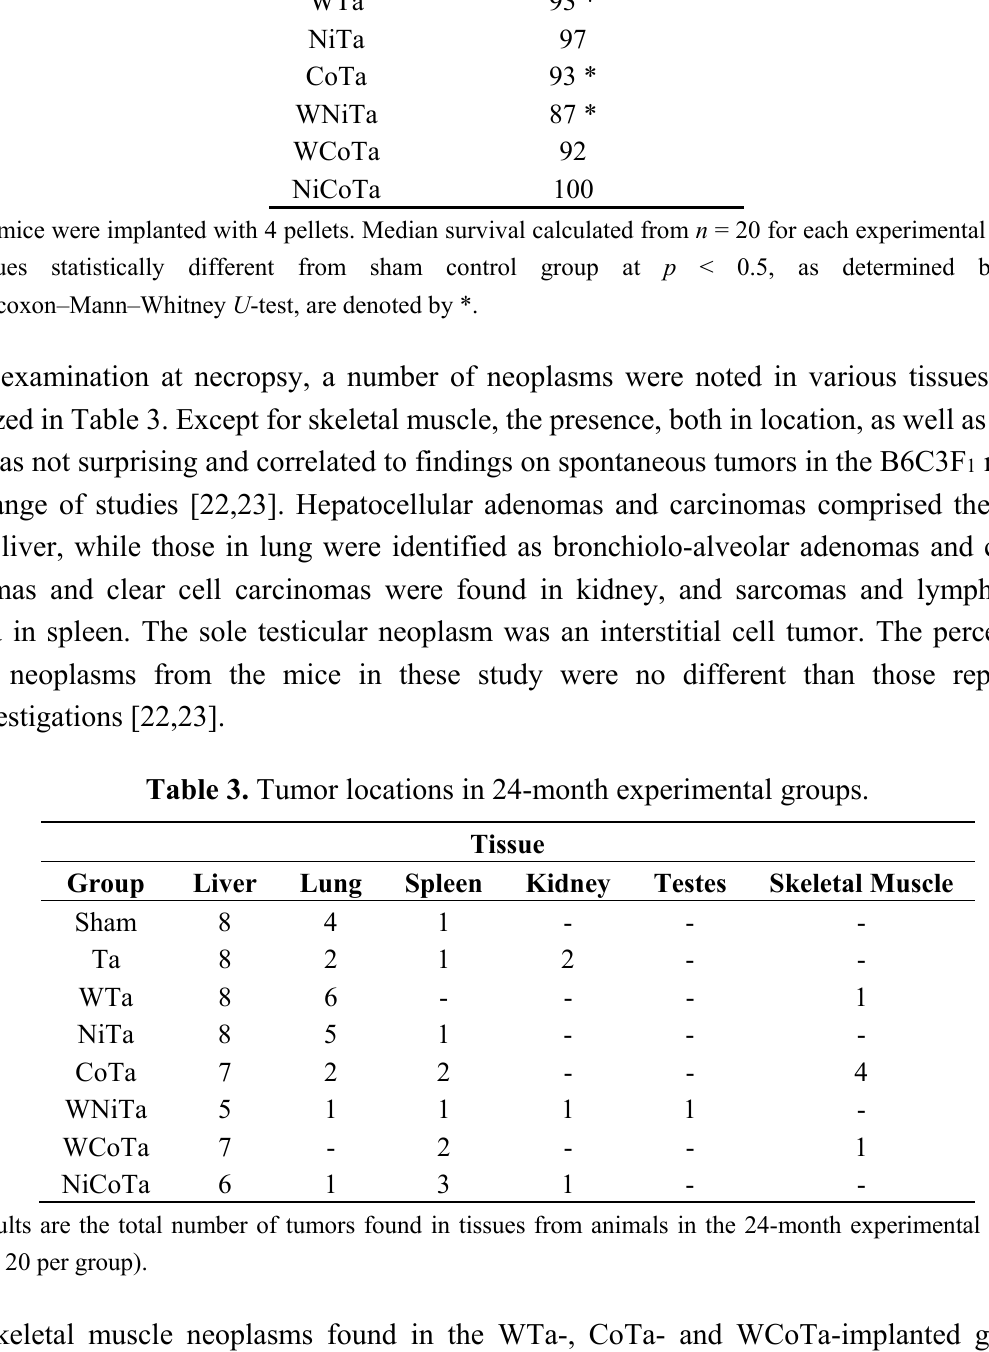
Table 2. Median survival times of metal-implanted mice. Group